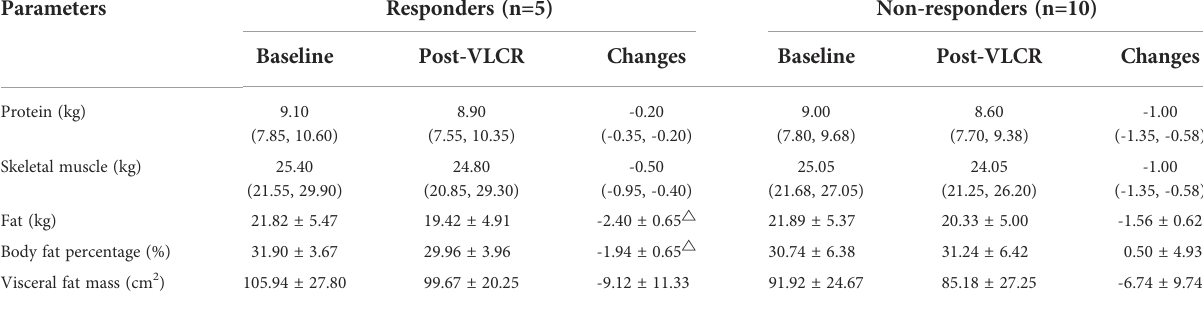
TABLE 5 Body composition before and after VLCR in responders and non-responders.